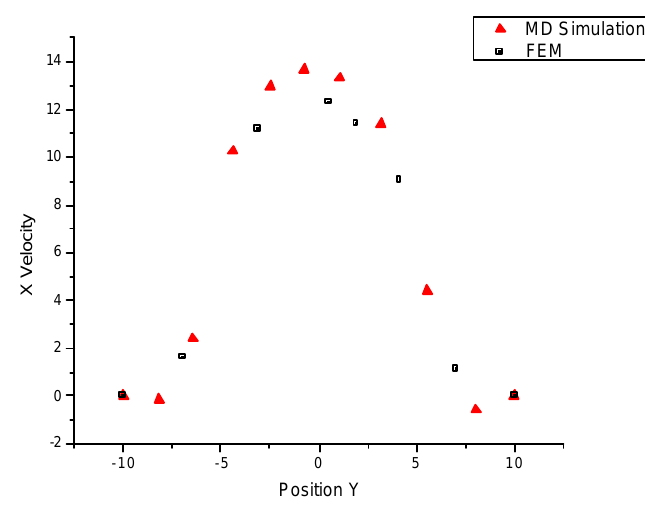
Figure 9. X velocity profile at position x=105 in Case 4